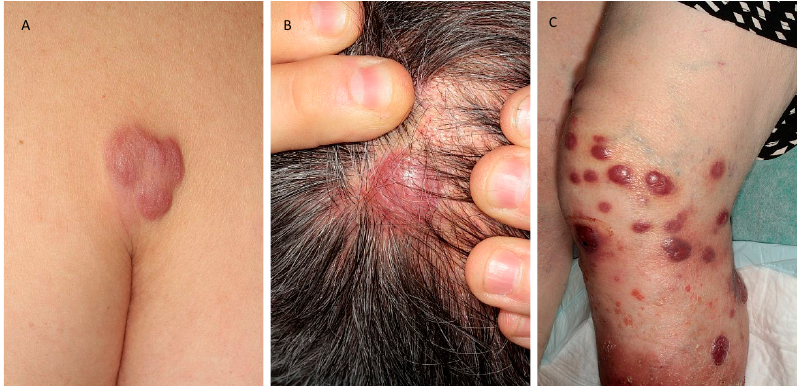
Figure 1. Clinical presentations of the three main subsets of primary cutaneous B-cell lymphomas. ( A ) Primary cutaneous marginal zone lymphoma; ( B ) primary cutaneous follicle center lymphoma; ( C ) primary cutaneous diffuse large B-cell lymphoma.